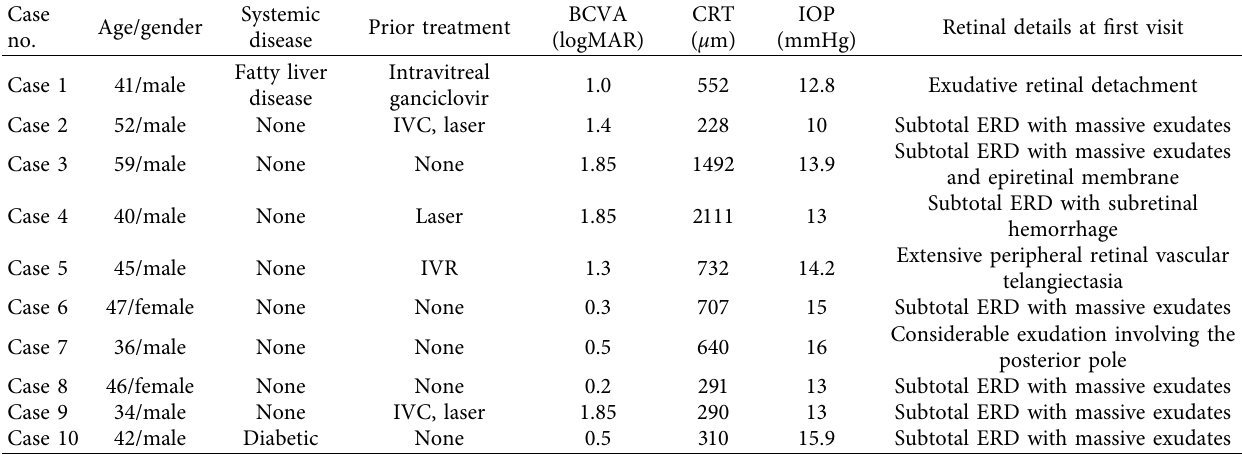
Table 2: Baseline clinical characteristics of patients with Stage 3A Coats’ disease.